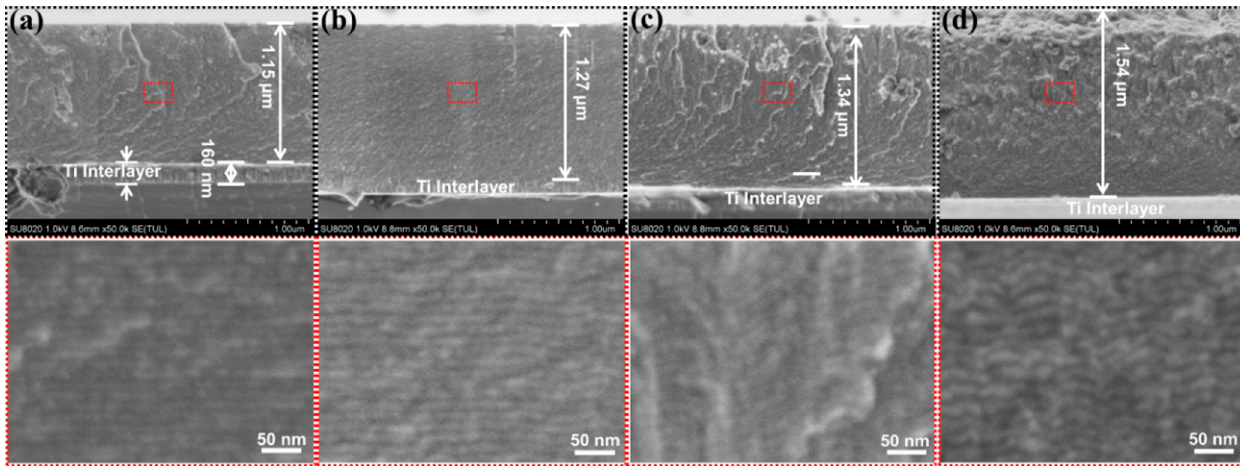
Figure 3. Cross-sectional FESEM morphologies of the multilayered films with different target currents of graphite: ( a ), 6 A; ( b ), 8 A; ( c ), 10 A; ( d ), 12A and their corresponding high resolution cross-sectional morphologies with red wire-frame.